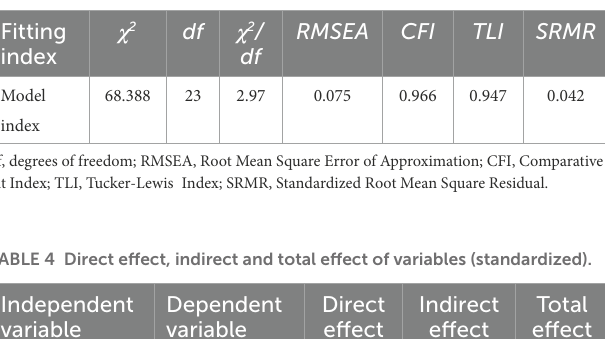
TABLE 3 Fitting indexes of the mediating effect model.